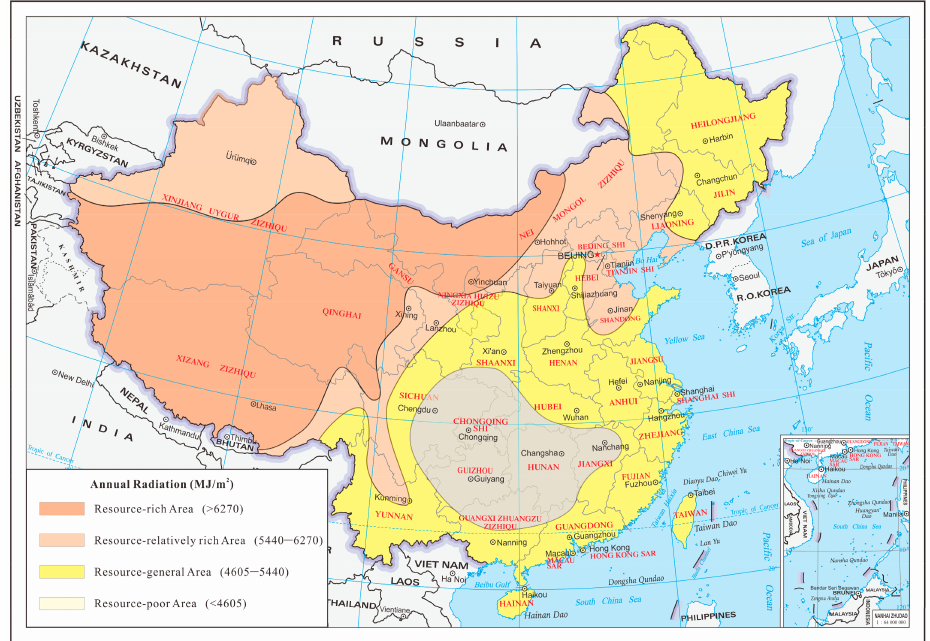
Figure 2. Regionalization of China’s solar radiation